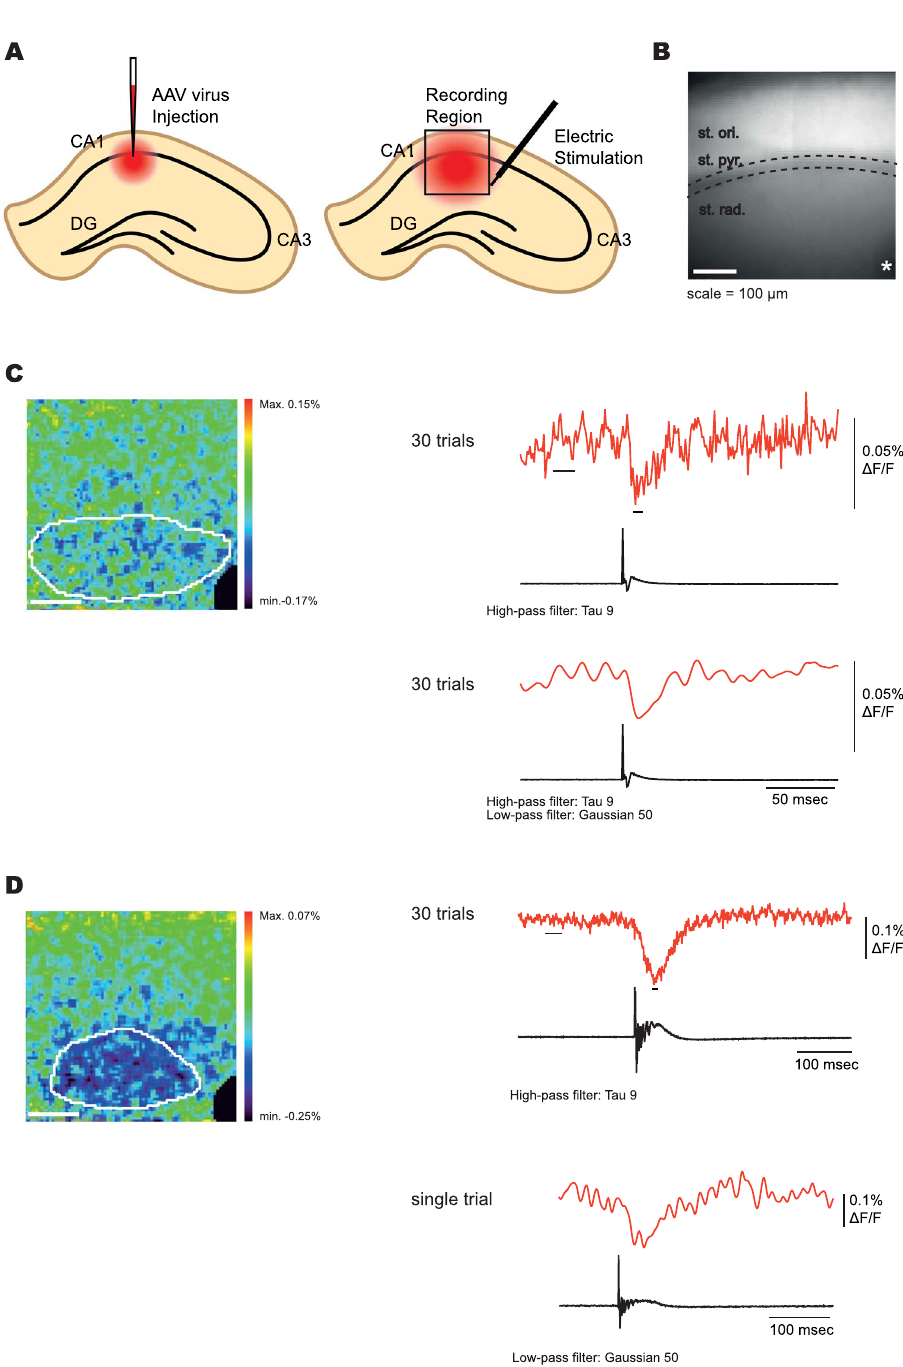
Figure 6. Population recording from mouse brain slice with Ilmol. ( A ) Schematic of the injection site into the CA1 region of the mouse brain. ( B ) The resting light image of an acute brain slice expressing Ilmol. The pyramidal cell layer resides inside the dotted lines. The asterisk denotes the site of the stimulating electrode. An electrode recording the field potential was placed in the pyramidal cell layer. ( C ) Heat map of neuronal activity. The image is the same as in B. The fluorescence trace (red) is from all of the pixels inside the white circle in the heat map. The heat map was generated by subtracting the average of five frames post stimulation (indicated by black dash under the fluorescence trace) from the average of 20 frames pre-stimulation (represented by the bar below the fluorescence trace). The field potential recording is shown in the black trace below to indicate the onset of stimulation. The stimulation electrode was masked (black pixels in lower right hand corner). ( D ) Effect of bicuculline on neuronal activity. The heat map was generated in a similar fashion as in C. Fluorescence traces again correspond to the pixels inside the white circle. Top fluorescence trace is the average of 30 trials. Bottom fluorescence trace is of a single trial. Offline filtering is as indicated below each trace. All recordings were done at 1000 frames per second. Light intensity was 500 mW/cm 2